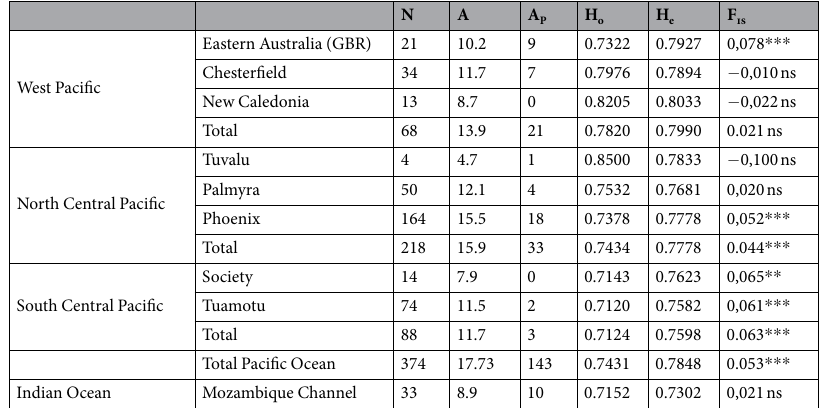
Table 1. Summary statistics of the nine sampling localities of gray reef sharks collected in the Indian and the Pacific Oceans. N = number of specimens analyzed; A = Mean number of alleles; A P = Number of private alleles; H o = observed heterozygosity; He = non-biased expected heterozygosity; F is = inbreeding coefficient and its significance: ns = non-significant, ** significant at p < 0.01 and *** at p < 0.001.